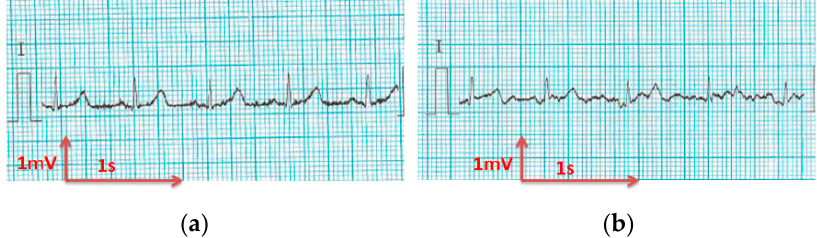
Figure 10. ECG signal obtained by 100% cotton electrodes with 7.4 wt.% PEDOT:PSS: ( a ) before washing; ( b ) after 50 washing cycles.